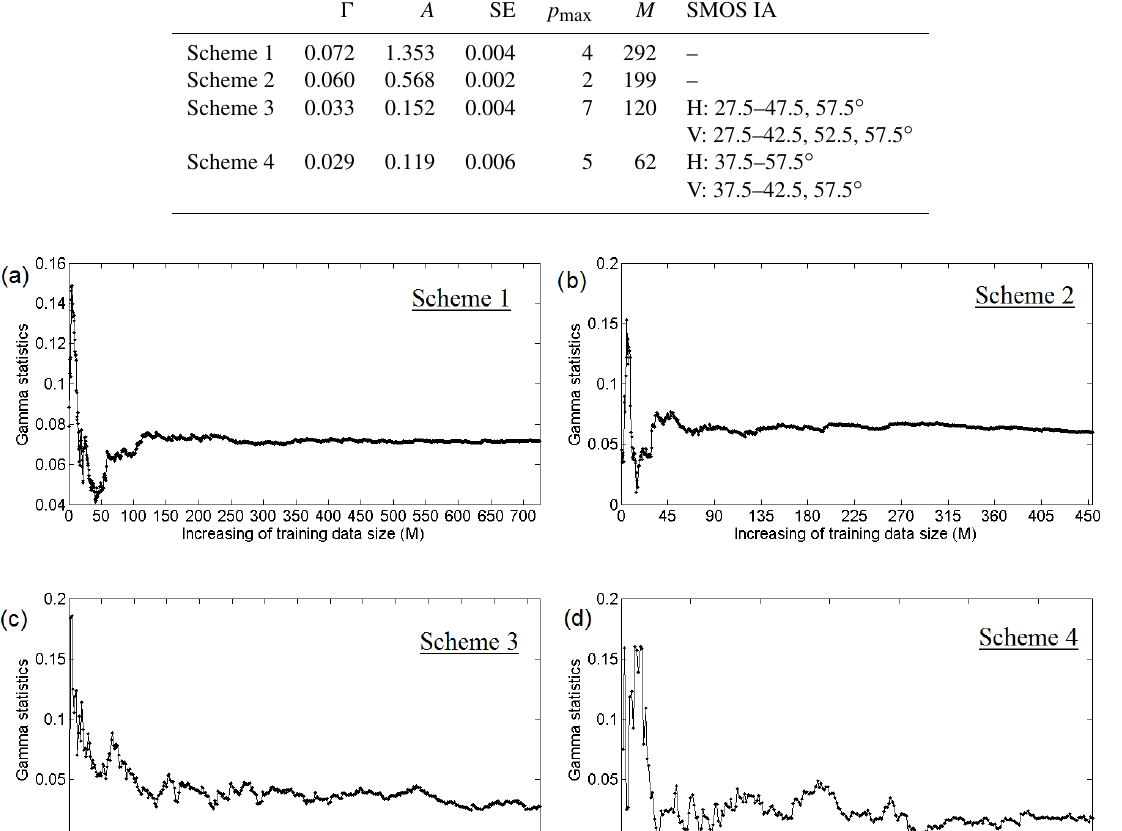
Table 4. Model statistical performances and modelling information, where (cid:48) is the calculated gamma statistic, which is the minimum MSE that can be achieved from a modelling method; A is the gamma gradient; SE is the Standard error; p max is the nearest points for LLR modelling; M is the training data size; and SMOS IA is the chosen incidence angle of SMOS- T b s.